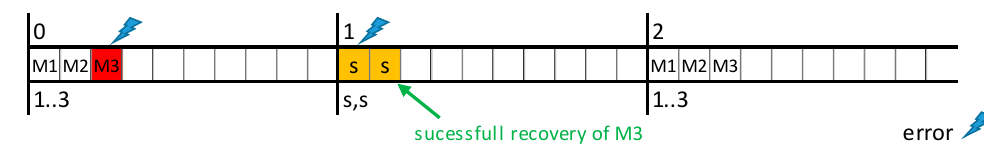
Figure 4. Message and replica hit by errors.